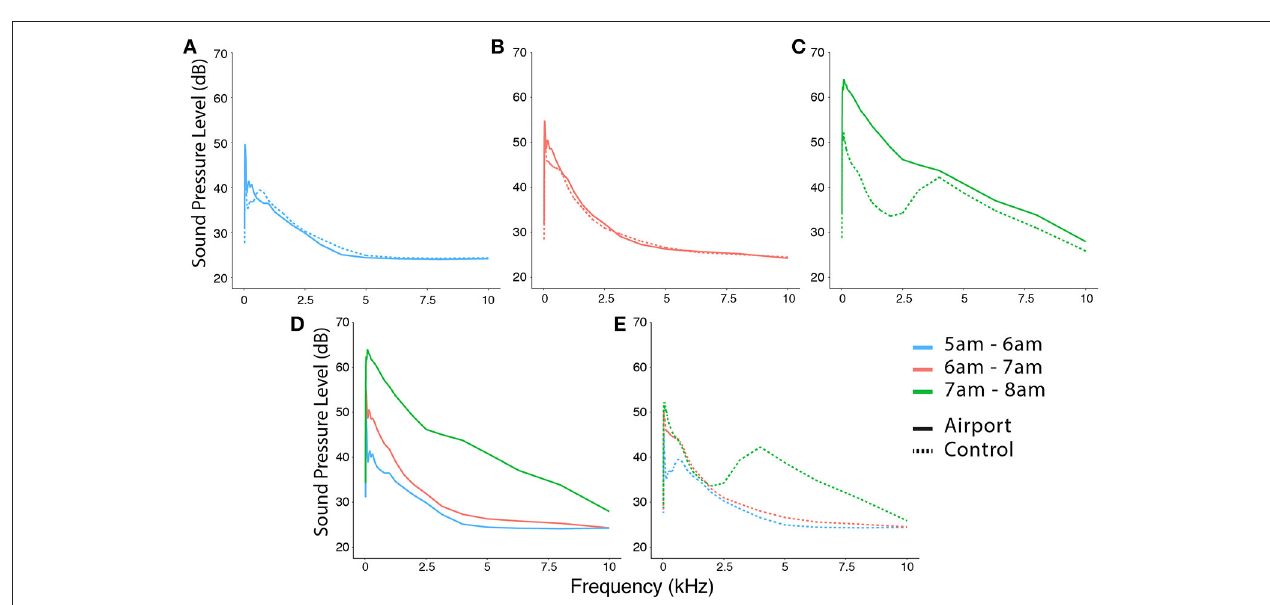
FIGURE 3 | (A–C) show the noise distribution along the spectrum during the three time intervals defined previously: “no traffic,” “traffic runway 3,” and “traffic runway 4.” In each of these three plots, dashed lines represent the control site and continuous lines represent the airport site. We can see that both sites are very similar in (A,B) but this changes dramatically in (C) that shows the start of the noise produced by the day-time traffic. Here we can appreciate how aircraft noise overlaps at least partially with the frequencies typical of bird vocalizations whose normal representation in a quiet forest looks similar to the control curve. Finally, (D,E) show the three time intervals plotted together for each study site separately illustrating more clearly the increase of noise at dawn.